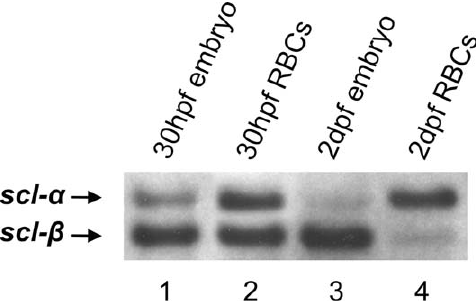
Figure 5. The scl- a and - b Transcripts in 30-hpf and 2-dpf Embryos and RBCs Virtual Northern blotting shows that 30-hpf RBCs express both scl- a and - b (lane 2) whereas 2-dpf RBCs express predominantly scl- a (lane